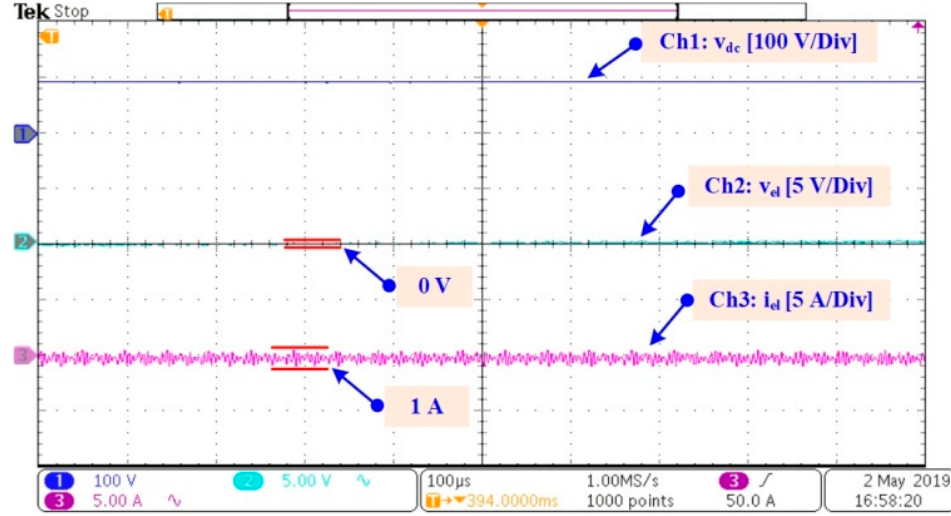
Figure 12. PEM EL voltage ripple and current in steady state conditions with AC coupling (V dc = 100 V): channel 1: DC bus voltage (v dc ), channel 2: PEM EL voltage (v el ), channel 3: PEM EL current (i el ).